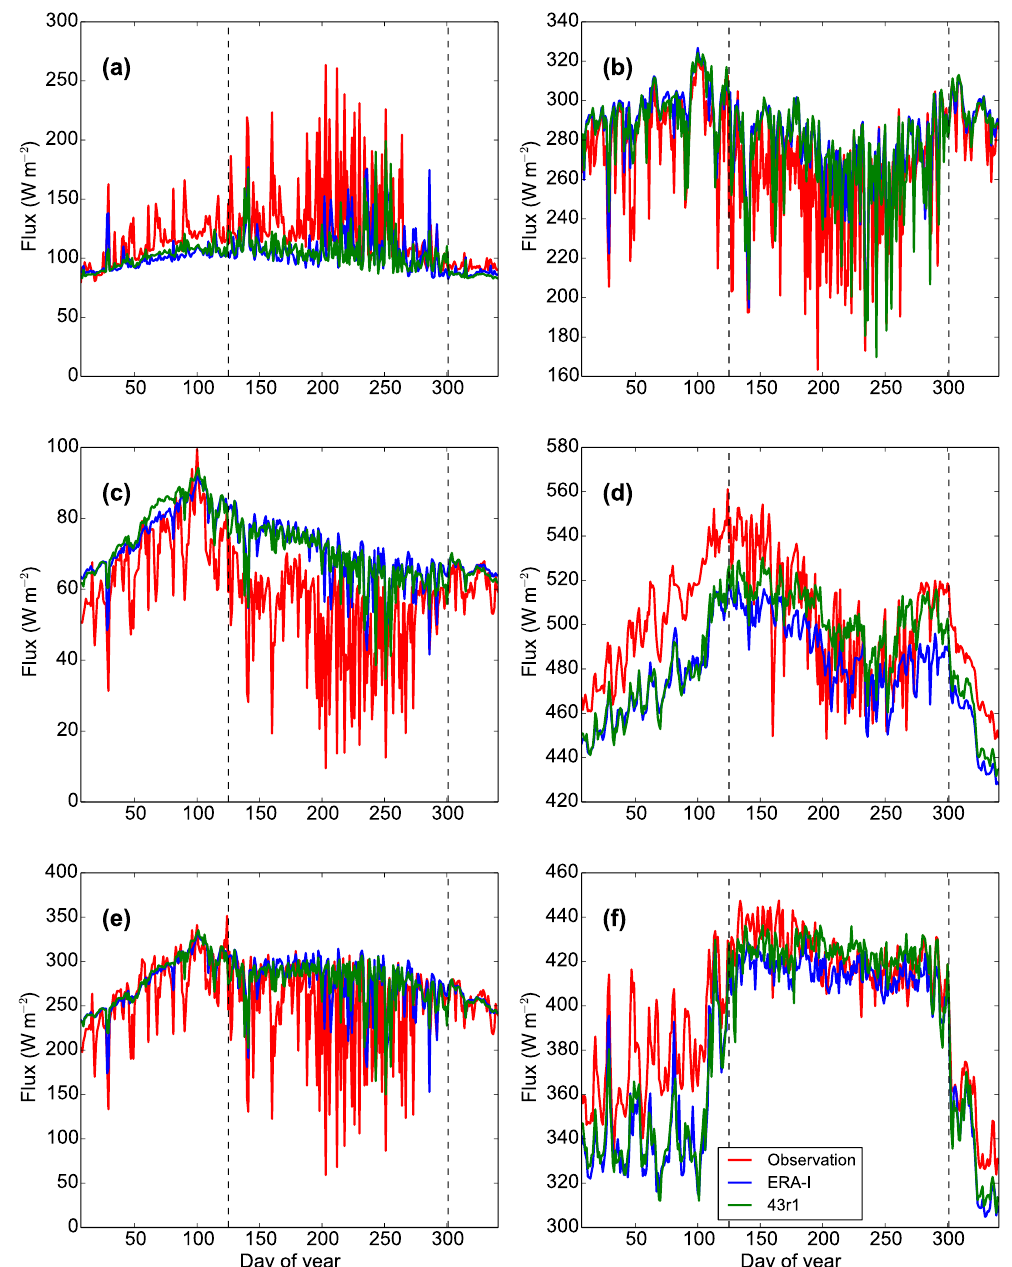
Figure showing ERA-Interim and IFS cycle 43r1 differences, as discussed in Sect. 4.